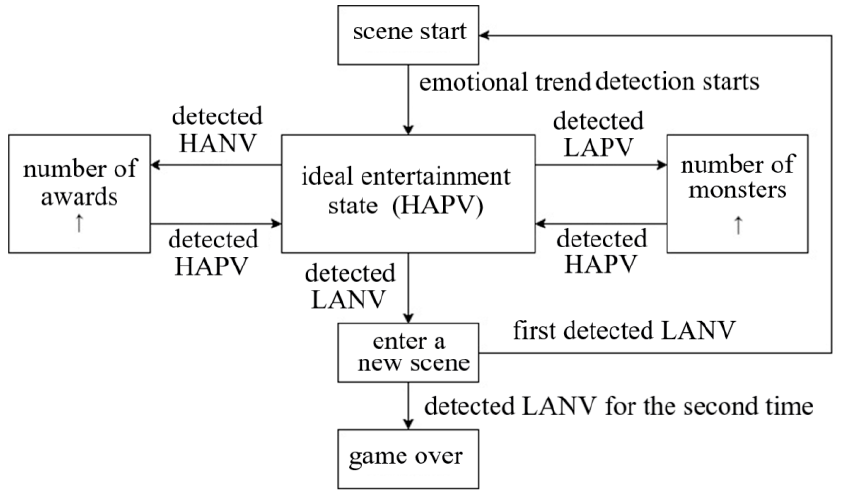
Figure 4. Special event activation conditions.